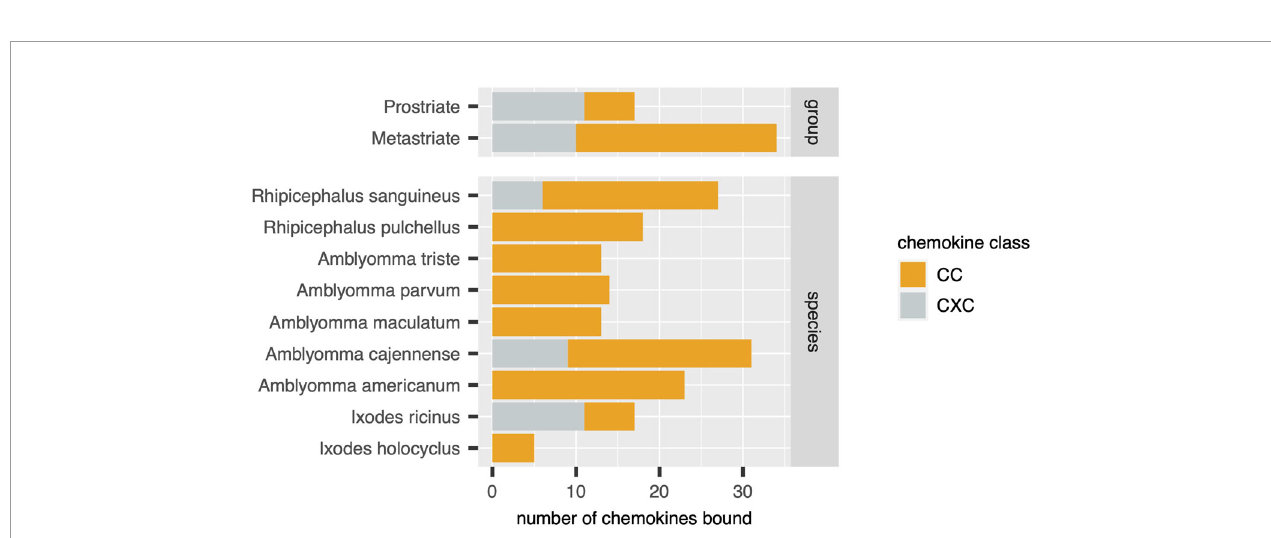
FIGURE 4 | Distribution of chemokines bound by biochemically characterized evasins in diverse tick species. Stacked bar charts showing the numbers of distinct chemokines by class (x-axis, coloured as indicated in the guide) in tick groups (top panel) and in individual tick species (bottom panel).